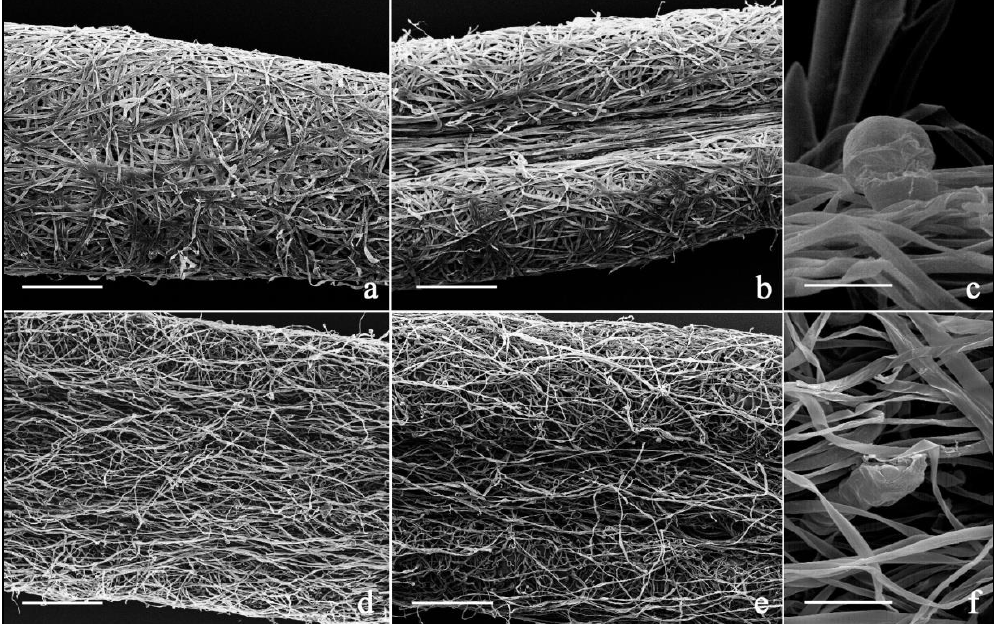
Figure 2. ( a – f ). SEM micrographs showing the distribution pattern of trichome morphotypes in the investigated Helichrysum populations. ( a – c ). Population A samples: leaf adaxial ( a ) and abaxial sur- faces ( b ) covered with long filamentous non-glandular trichomes; particular of the apical cells of a club-shaped glandular trichome ( c ). ( d – f ). Population B samples: leaf adaxial ( d ) and abaxial sur- faces ( e ) covered with long filamentous non-glandular trichomes; particular of the apical cells of a club-shaped glandular trichome ( f ). Scale bars = 200 μm ( a , b , d , e ); 25 μm ( c , f ).